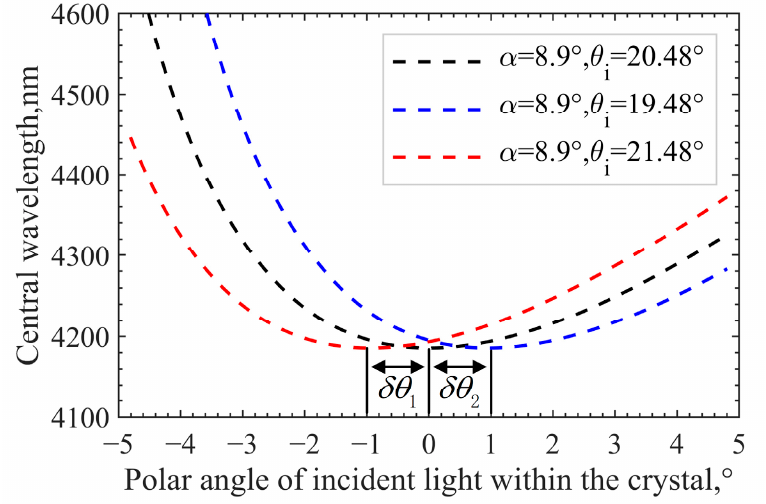
Figure 4. Influence of the GPC on spectral response.